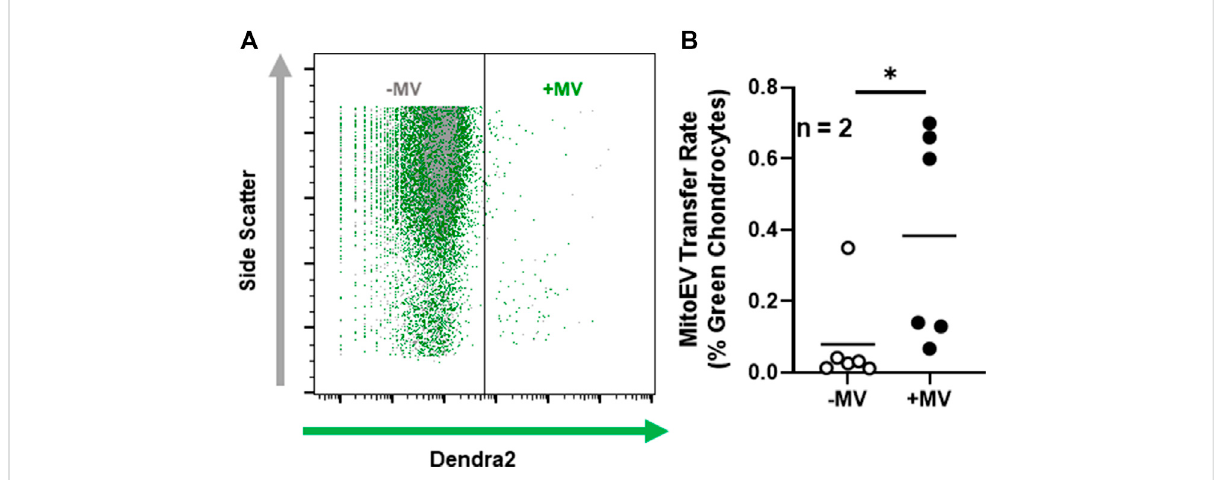
FIGURE 5 Chondrocytes take up MSC-derived MT following incubation with MitoEVs (A) Representative fl ow cytometry plots of chondrocytes incubated with (+MV) and without (-MV) microvesicles isolated from MSCs expressing endogenous, MT-speci fi c dendra2 fl uorescence. Dendra2 (green) threshold was set using control chondrocytes. Events fl uorescing above threshold were considered chondrocytes having taken up mitoEVs. (B) Quanti fi cationofmitoEVuptakebychondrocytesinculture( n =2)revealsthe+MVgrouphadahigherrateoftransfereventsthan-MV.Dataare expressed as the fraction of chondrocytes above threshold for green fl uorescence. * = p ≤ 0.05, by one-way